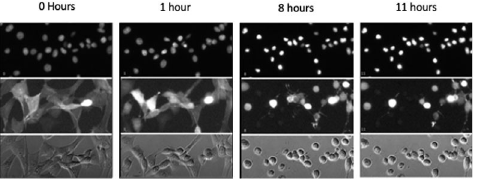
Fig 5. Cell death images from canine osteosarcoma cell line UWOS-2. UWOS-2 was exposed to CT at 20 μ M concentration for 24 hours. Serial images of the cells over the first 12 hours of incubation are presented here. The top two panels include fluorescent images of the cells (top panel nuclei are stained; middle panel actin fibers are stained) and the bottom panel includes the images of unstained cells.